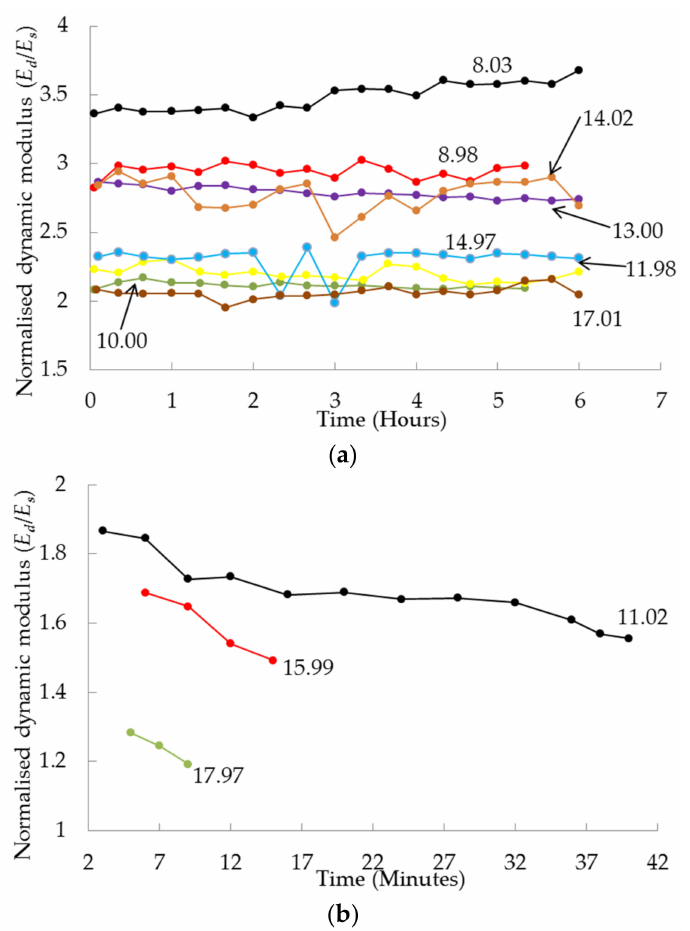
Figure 10. Normalised dynamic moduli versus time during creep tests for: ( a ) unbroken samples; ( b ) broken samples. The numbers denote the samples tested at 8.03 MPa, 8.98 MPa, 10.00 MPa, 11.02 MPa,